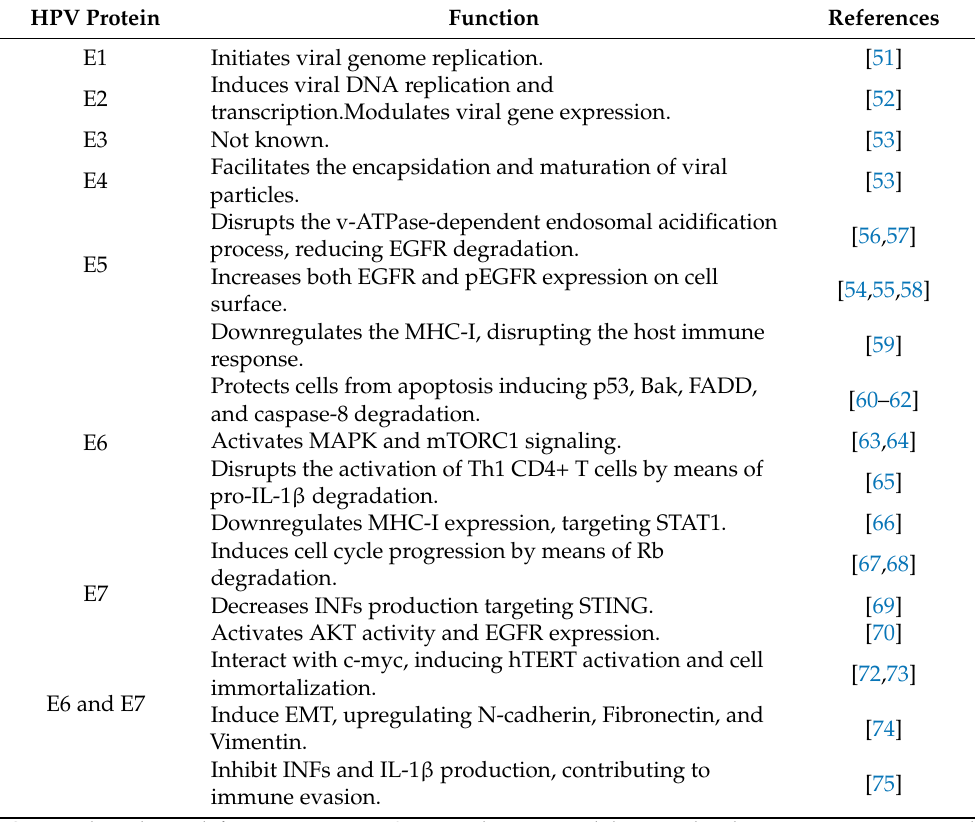
Table 1. Biological functions of HPV oncoproteins.